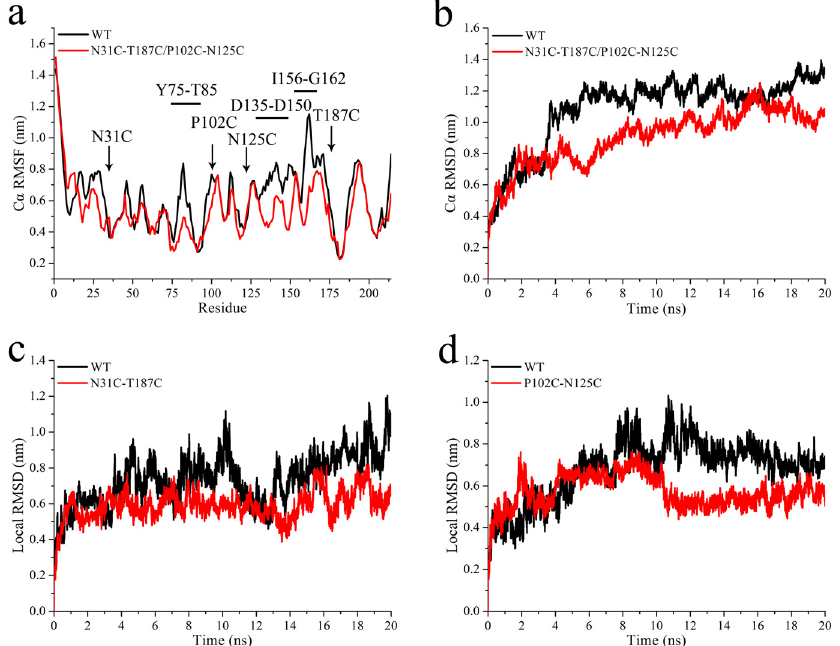
Fig 3. Comparison of RMSF curves (a), overall RMSD curves (b) and local RMSD curves in mutant regions N31C-T187C (c) and P102C-N125C (d) of wild-type BglTM and N31C-T187C/P102C-N125C mutant by MD simulation at 500K for 20